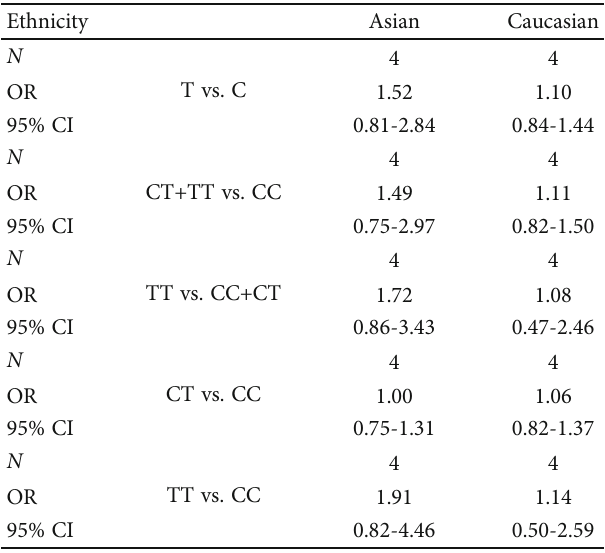
Table 4: Subgroup analysis by ethnicity associated with MTHFR C677T gene polymorphisms and MCI